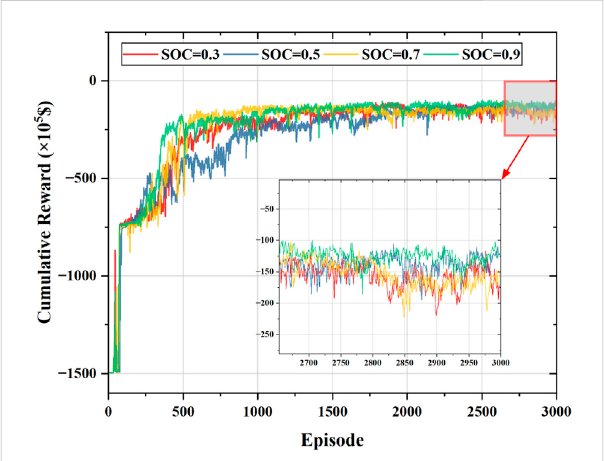
FIGURE 7 Convergence curves of the cumulative rewards of the proposed approach with different initial values of the